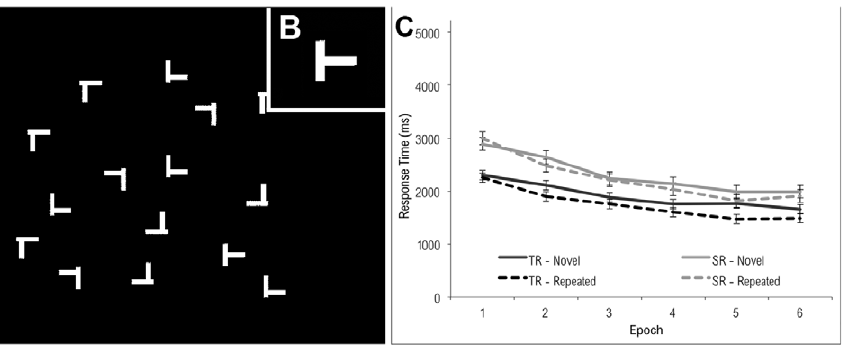
Figure 2. Example of stimulus used in Experiment 1. Participants search for and identify a side-facing T-shaped target, and indicate its direction left or right. The spatial context (A) is defined by a field of L-shaped objects, doglegged to resemble the target (B), inset. Manual response times for Experiment 1 are plotted in (C). Both typical readers and individuals with dyslexia show progressively faster search times in both the repeated and novel conditions, revealing a well-known practice effect associated with this task. Response times for repeated trials are generally shorter than for novel trials, and this difference grows as a function of epoch, indicative of a contextual cueing effect ascribed to spatial learning. The contextual cueing effect was equivalent for both SR and TR groups.